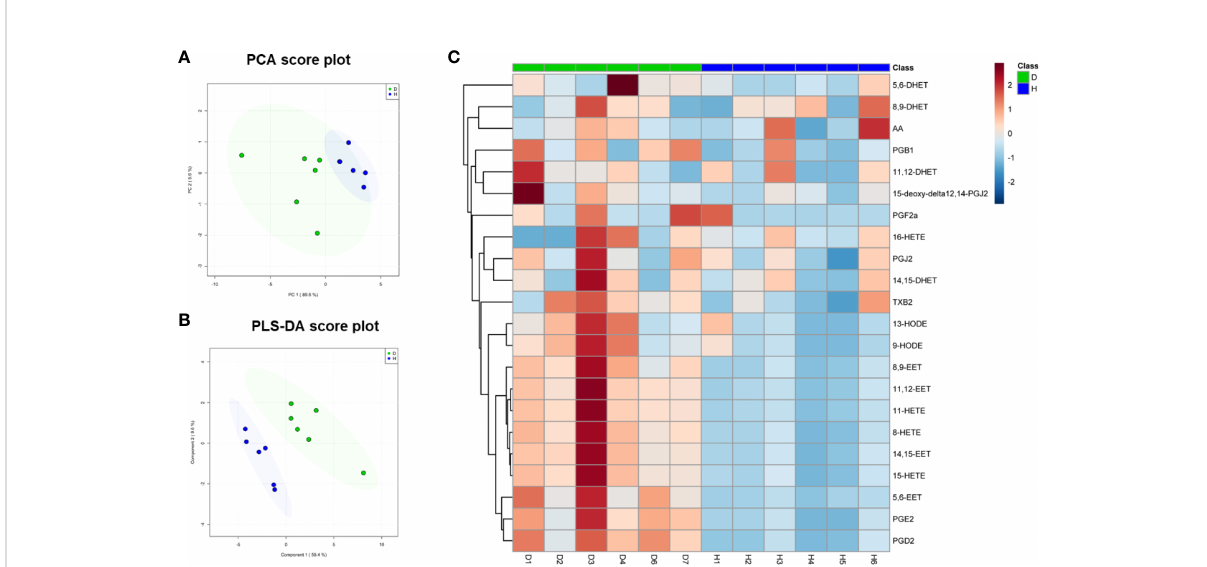
FIGURE 2 Multivariate analysis of the oxidized fatty acid lipidome of HDL from diabetic subjects and healthy controls in Study 1. (A) Principal Component Analysis (PCA) and (B) Partial Least Squares Discriminant Analysis (PLS-DA) of HDL from diabetic patients (D, n=6) and healthy subjects (H, n=6). The shaded areas indicate 95% con fi dence ellipse regions based on the data points for individual groups. (C) Heatmap visualization based on the signi fi cantly changed oxidized fatty acids (fold change ≥ 1.5, p <0.05). Colors in the heatmap correspond to normalized abundance of each metabolite by a gradient of color from blue (low abundance) to red (high